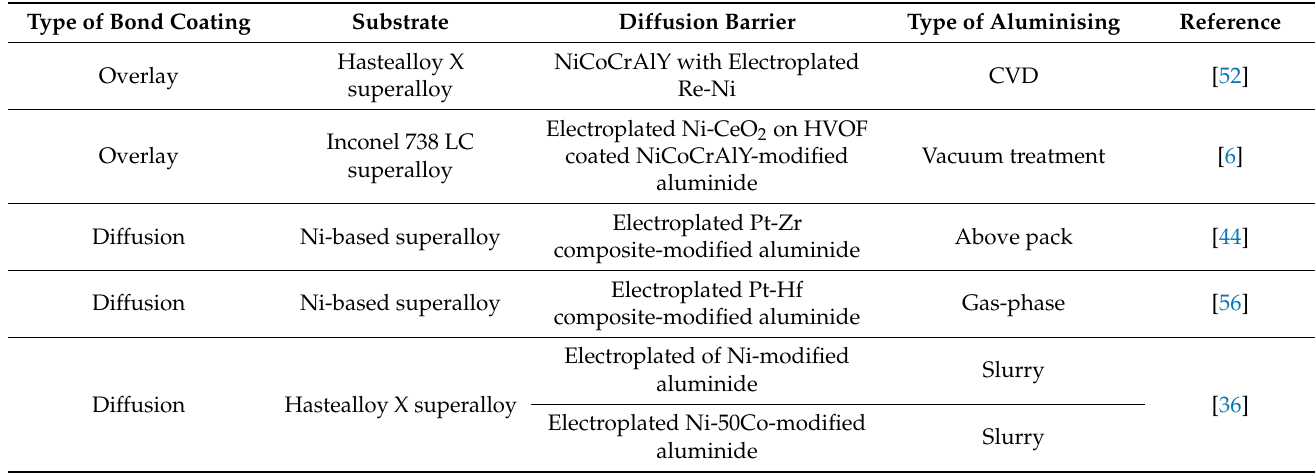
Figure 2. The evolution of bond coats utilising electrodeposition method as an effective strategy. Table 1. The bond coatings prepared by electrodepositing metals with or without incorporating dopants employing different aluminising